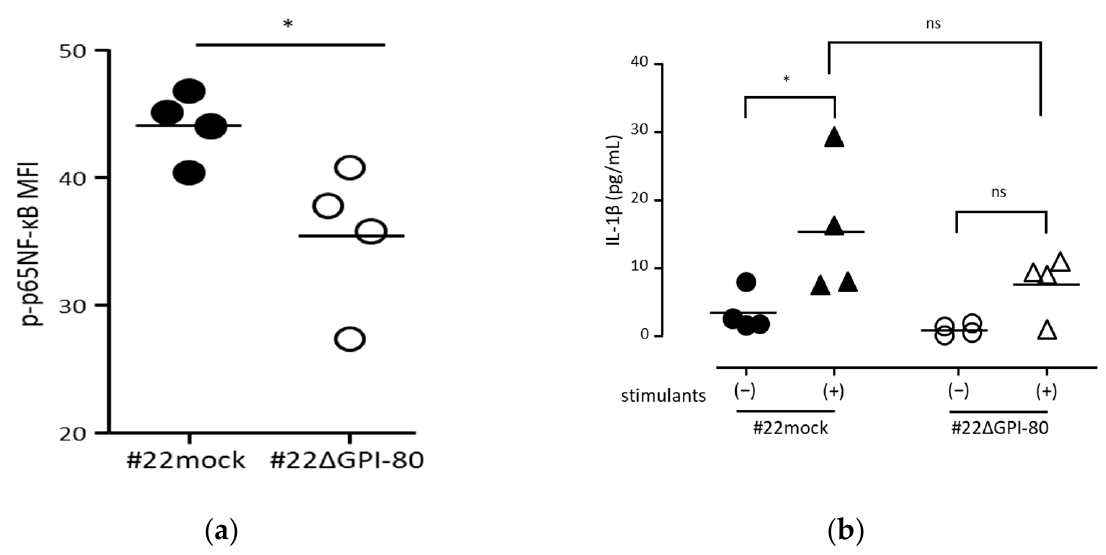
Figure 4. GPI-80 expression augmented NF- κ B activation. ( a ) Measurement of phosphorylated p65-NF- κ B levels. The levels of phosphorylated p65-NF- κ B in #22mock (closed circle) and #22 ∆ GPI-80 (open circle) cells were measured by flow cytometry, and the mean fluorescence intensity (MFI) of phosphorylated p65-NF- κ B (p-p65 NF- κ B) was analyzed. The data represent results from four independent experiments. The statistical significance was calculated using two-tailed unpaired Student’s t -test (*, p < 0.05). ( b ) Measurement of IL-1 β levels. Cells [#22mock (closed symbol) and #22 ∆ GPI-80 (open symbol)] were incubated with (stimulants (+), triangle symbol) or without (stimulants ( − ), circle symbol) 10 µ g/mL LPS + 1 ng/mL PMA for 24 h. After incubation, the media were collected, and IL-1 β concentration in the media was measured. The data represent results from four independent experiments, and the statistical significance was analyzed by one-way ANOVA with Bonferroni’s post hoc test, compared between: #22mock stimulants ( − ) and #22mock stimulants (+); #22 ∆ GPI-80 stimulants ( − ) and #22 ∆ GPI-80 stimulants (+); and #22mock stimulants (+) and #22 ∆ GPI-80 stimulants (+) (*, p < 0.05; ns, not significant).